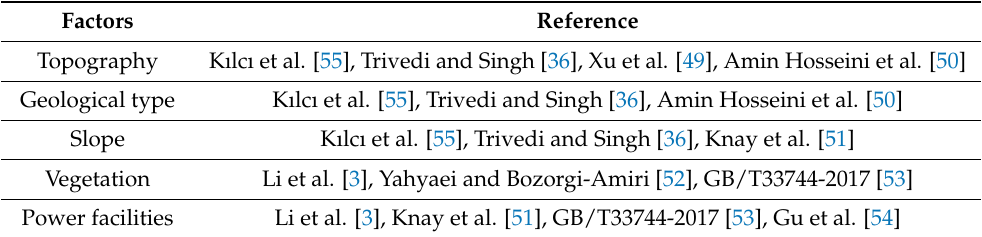
Table 1. Qualitative factors of shelter